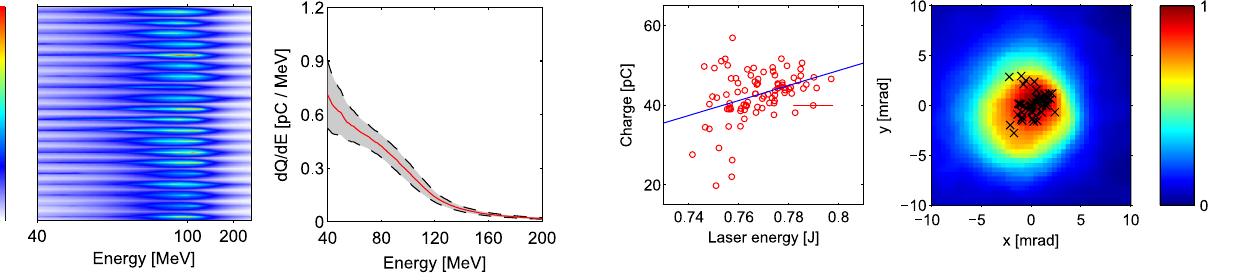
FIG. 4. In (a), the charge of the electrons in the beam, with energy above ∼ 40 MeV, is plotted as a function of laser pulse energy for the first 90 shots in Fig. 2, with the active pointing stabilization system on. The estimated measurement error in laser energy of 1% is marked as a solid red line only in one data point for clarity. This figure shows a clear correlation to laser energy. In (b), a typical beam profile is shown together with a scatter map of the centroids of a sequence of 30 shots with the pointing stabilization system